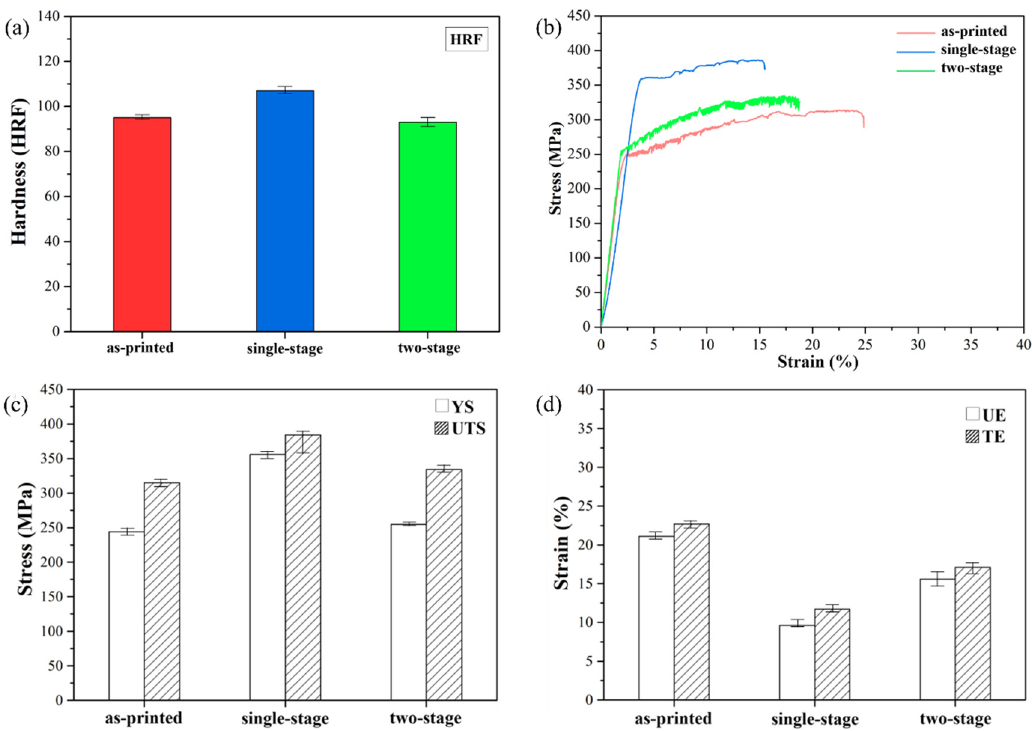
Figure 5. ( a ) Hardness, ( b ) tensile stress–strain curve, ( c ) tensile strength, and ( d ) elongation of the SLM Al–Mg–Sc–Zr alloys at room temperature (YS: yield strength, UTS: ultimate tensile strength, UE: uniform elongation, and TE: total elongation). Table 4. Average tensile properties and hardness of SLM Al–Mg–Sc–Zr alloys. YS (MPa) UTS (MPa) UE